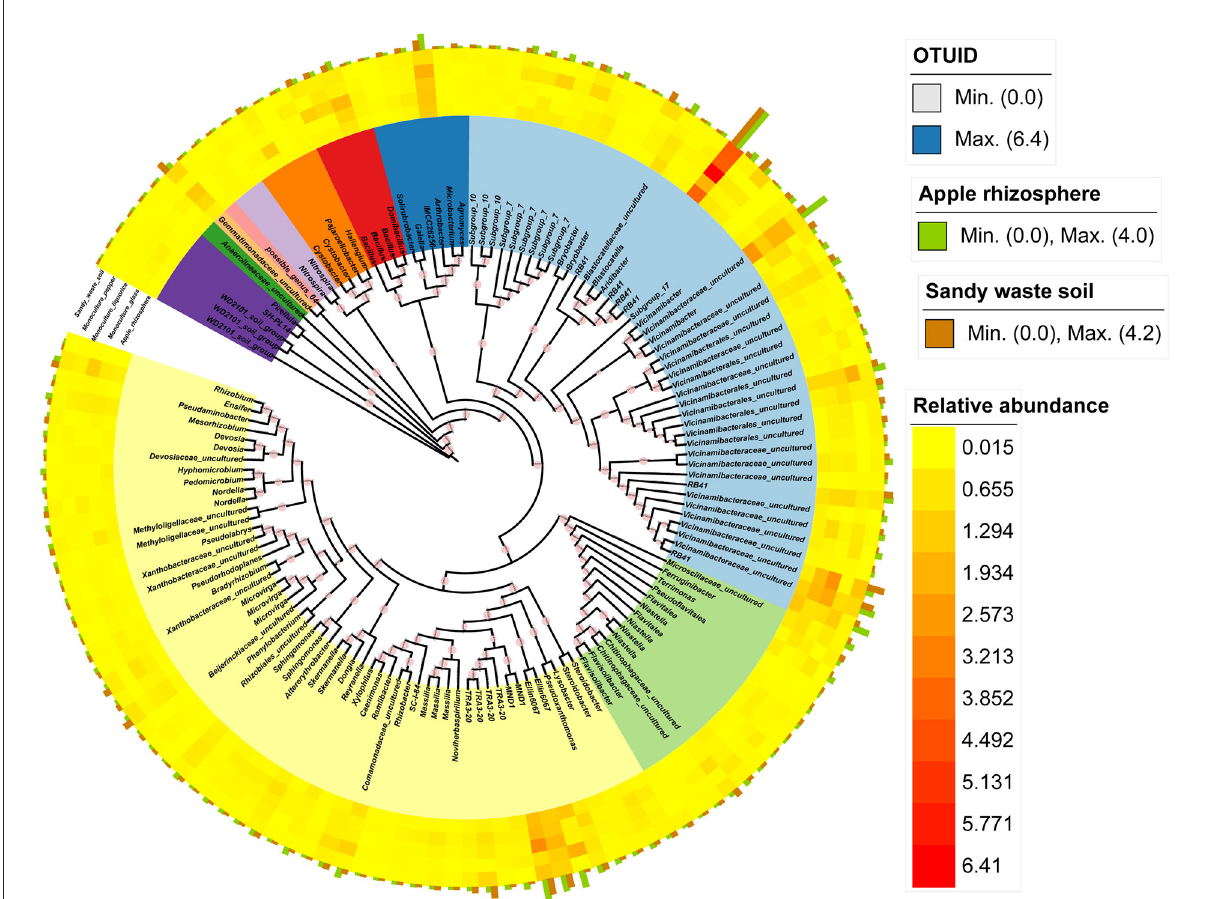
FIGURE3 Phylogenetic relationships among the core bacterial OTUs (present in > 90% of the analyzed samples). The annotated heatmap presents the relative abundance of core OTUs in different samples. The green bar plot presents the abundant core OTUs in apple, whereas the brown bar plot presents the abundant core OTUs in